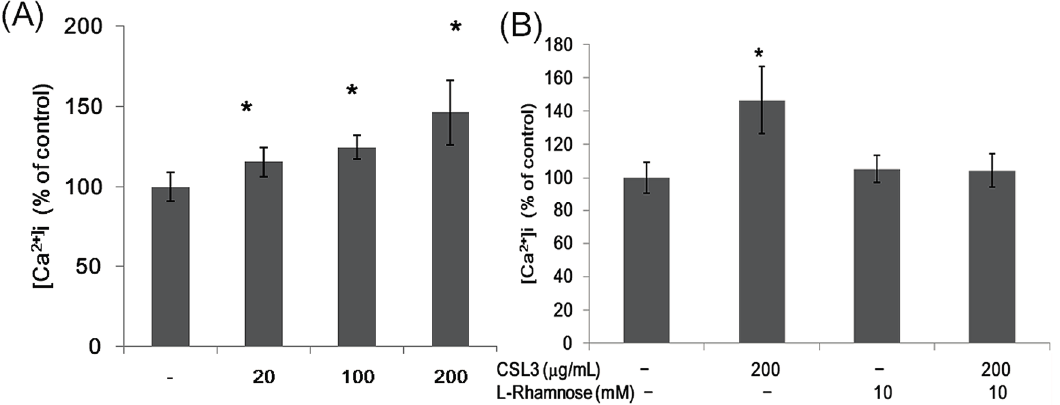
Figure 6. Effect of CSL3 on intracellular Ca 2+ ([Ca 2+ ] i ) of Caco-2 cell monolayers. ( A )